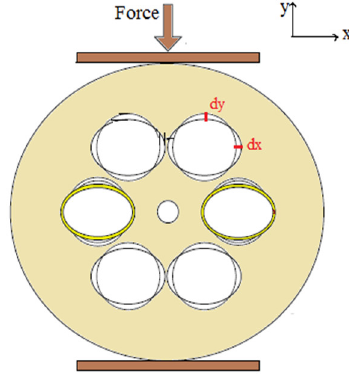
Figure 35. Cross-section of the designed magnetic fluids infiltrated dual core PCF magnetic field sensor and mode field pattern. This probe is useful for high magnetic field measurement (Reproduced from [34], with the permission of SPIE publishing).